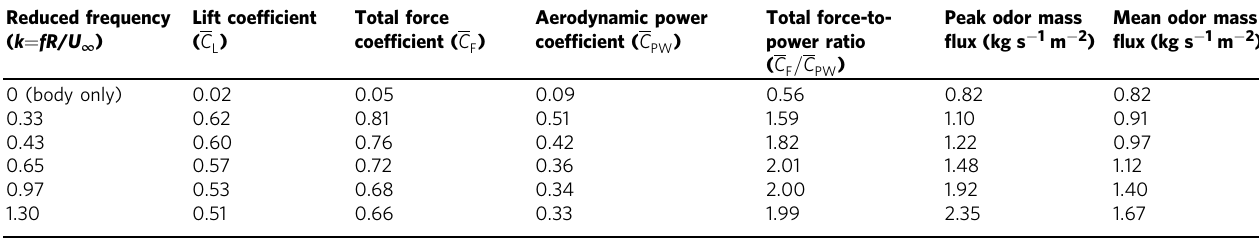
Table 1 Aerodynamic performance and odor mass fl ux over the antennae at various reduced frequencies Reduced frequency ( k = fR / U ∞